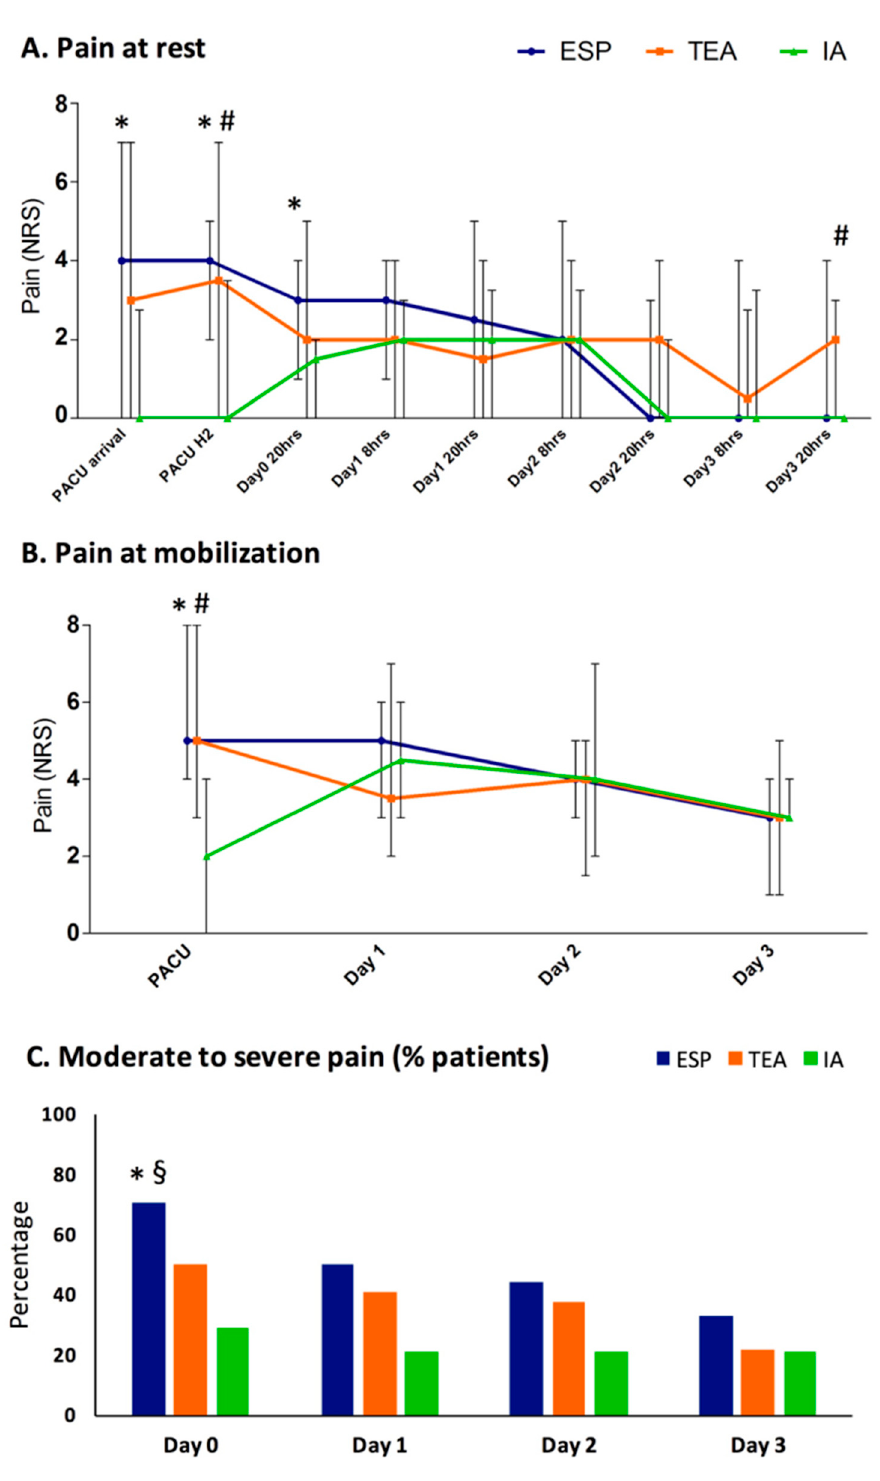
Figure 2. Postoperative pain in the three groups: ( A ) pain at rest; ( B ) pain during mobilization (during chest physiotherapy for Days 1 to 3); ( C ) percentage of patients with a moderate-to-severe pain (NRS ≥ 4). Points with blue line, ESP group; squares with orange line, TEA group; triangle with green line, IA group. The charts A and B show medians and (25–75%) interquartile range, and the chart C shows percentages. *, p < 0.05 between ESP and IA groups; #, p < 0.05 between TEA and IA groups; §, p < 0.05 between ESP and TEA groups. ESP, erector spinae plane block; IA, intrathecal analgesia; TEA, thoracic epidural analgesia; NRS, numerical rating scale of the pain; PACU, post-anesthesia care unit.